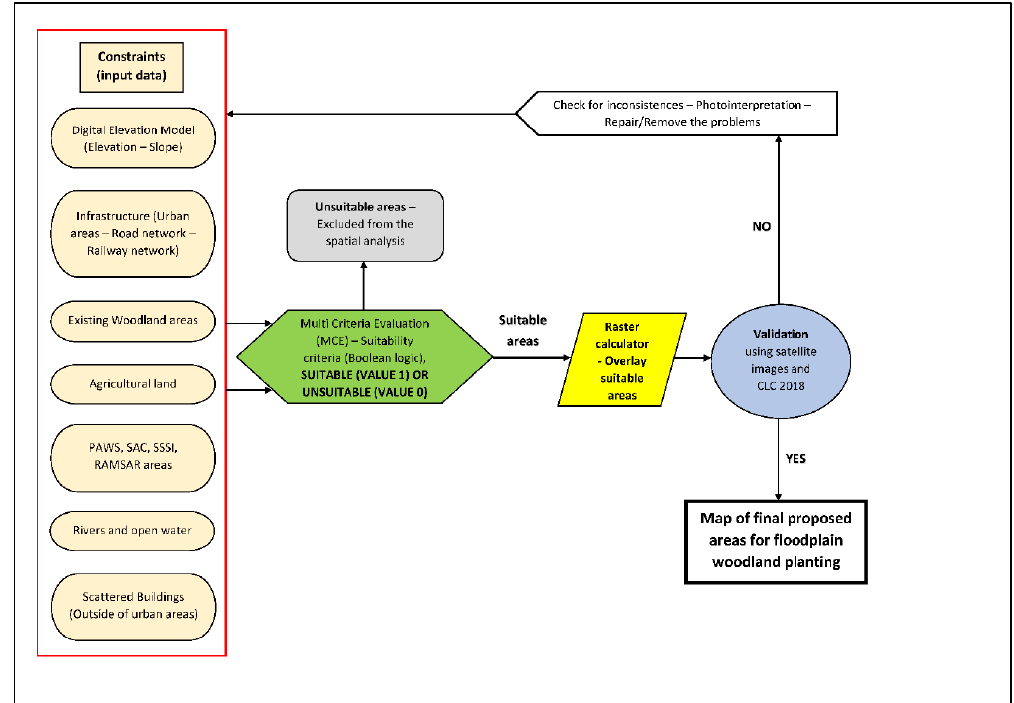
Figure 2. Flowchart of the methodology, data, models, and software that were used.